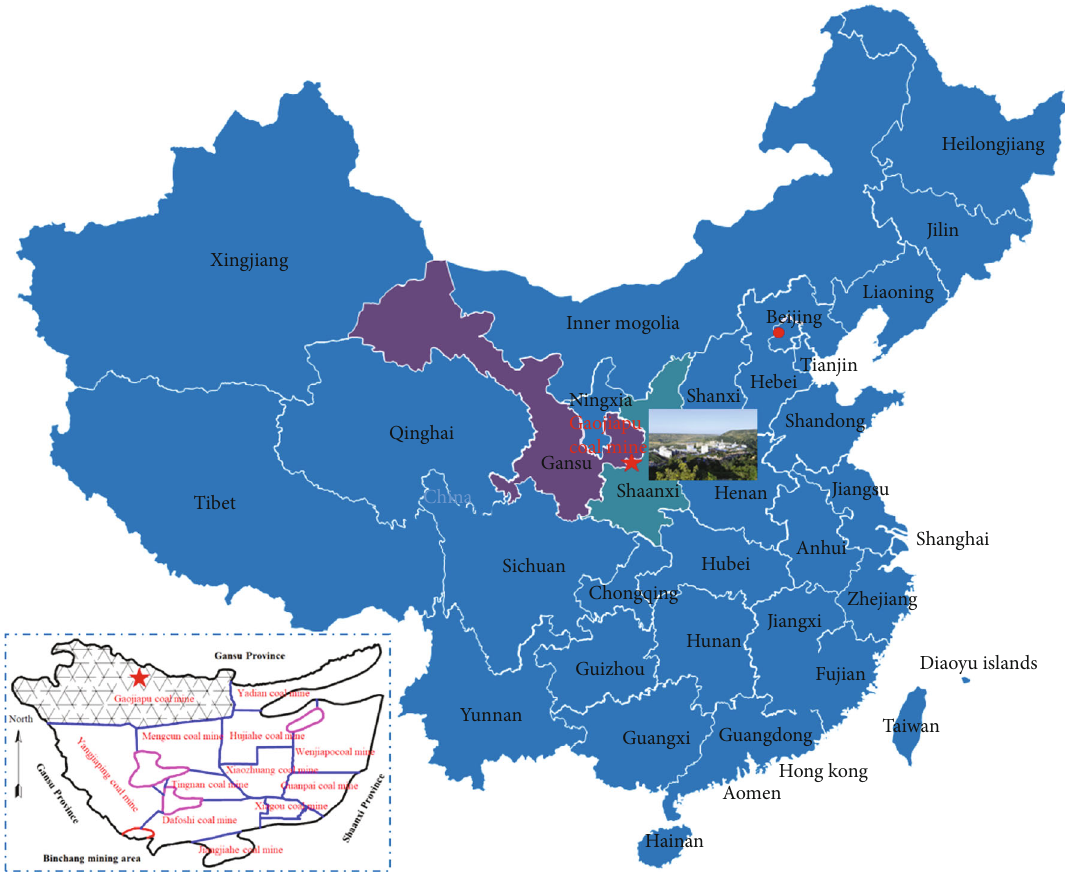
Figure 1: Geographical location of Gaojiapu coal mine and its surrounding coal mine distribution.